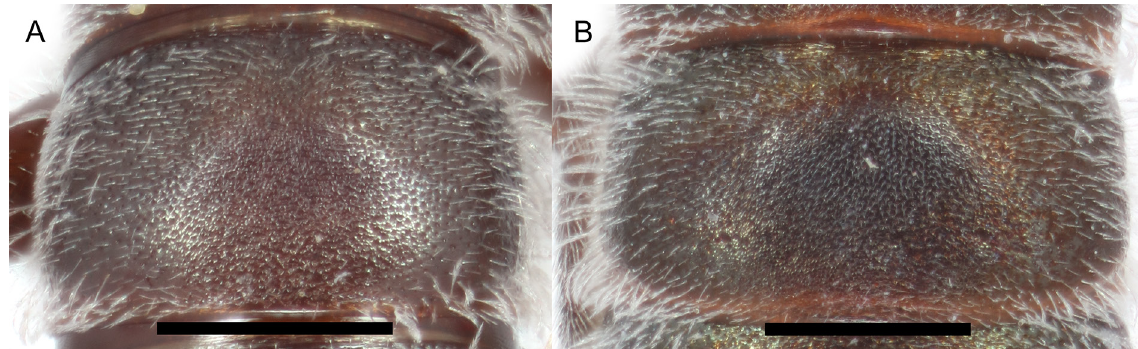
Fig. 112. T2. A . Lasioglossum ( D. ) petrellum (Cockerell, 1903), ♂, with weaker microsculpture and distinct punctures throughout. B . L. ( D. ) droegei Gibbs, 2009, ♂, with strong microsculpture and obscure punctures towards apical rim. Scale bars: 0.5 mm.